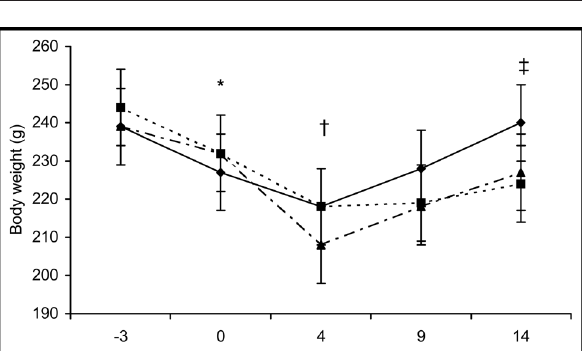
FIGURE 1 - Body weight of control (solid line), glutamine (dotted line) or glutamine + SCFA (dottedsolid line) animals over time. Values are means with their standard deviation represented by vertical bars. Not significant difference in comparison among groups. * = p < 0.05 vs. day –3 in all groups; † = p = 0.01 vs. day 0 in glutamine+SCFA group; ‡ = p = 0.04 vs. day 9 in control group.